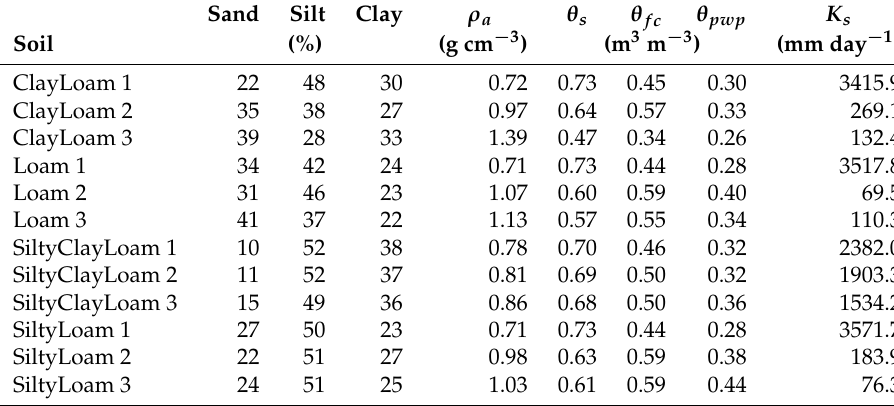
Table 2. Bulk density ( ρ a ), saturation ( θ s ), field capacity ( θ fc ), permanent wilt water content ( θ pwp ), and saturated hydraulic conductivity ( K s ) representative of the Central Valley of Chile. A constant soil depth of 2.3 m was considered and there was no influence from the water